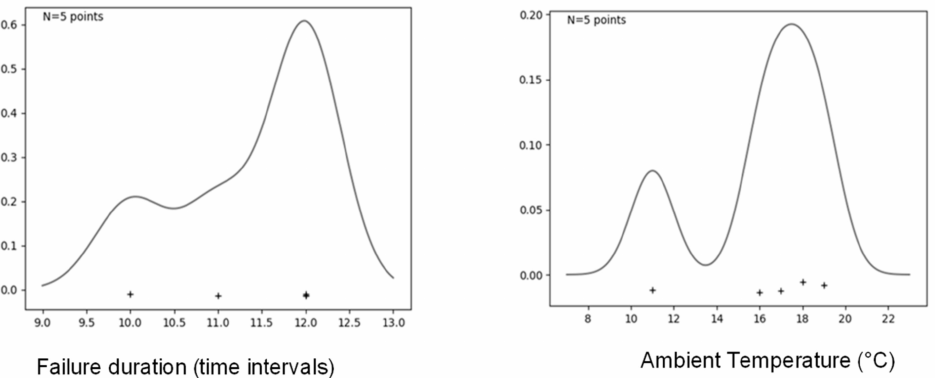
Figure 14. Probability density functions (continuous line) of the duration and ambient tempera- ture observed in the failure/anomaly instances from the real SCADA. Cross symbol represents real